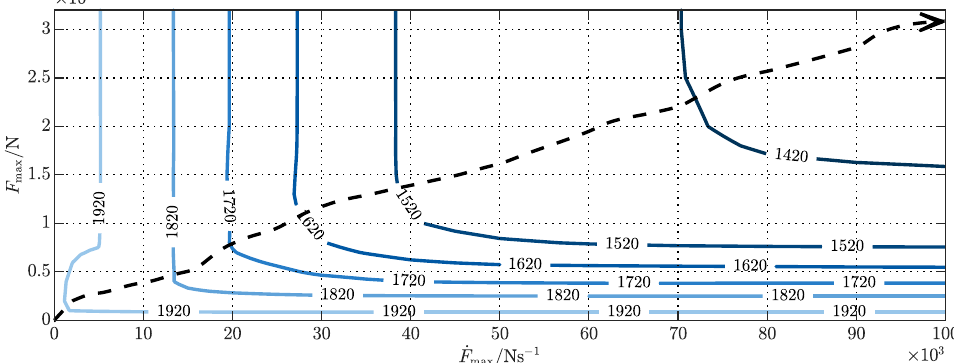
Figure 19. RMS body acceleration contour plot for the 90kmh − 1 BC profile dynamic wheel-load optimization